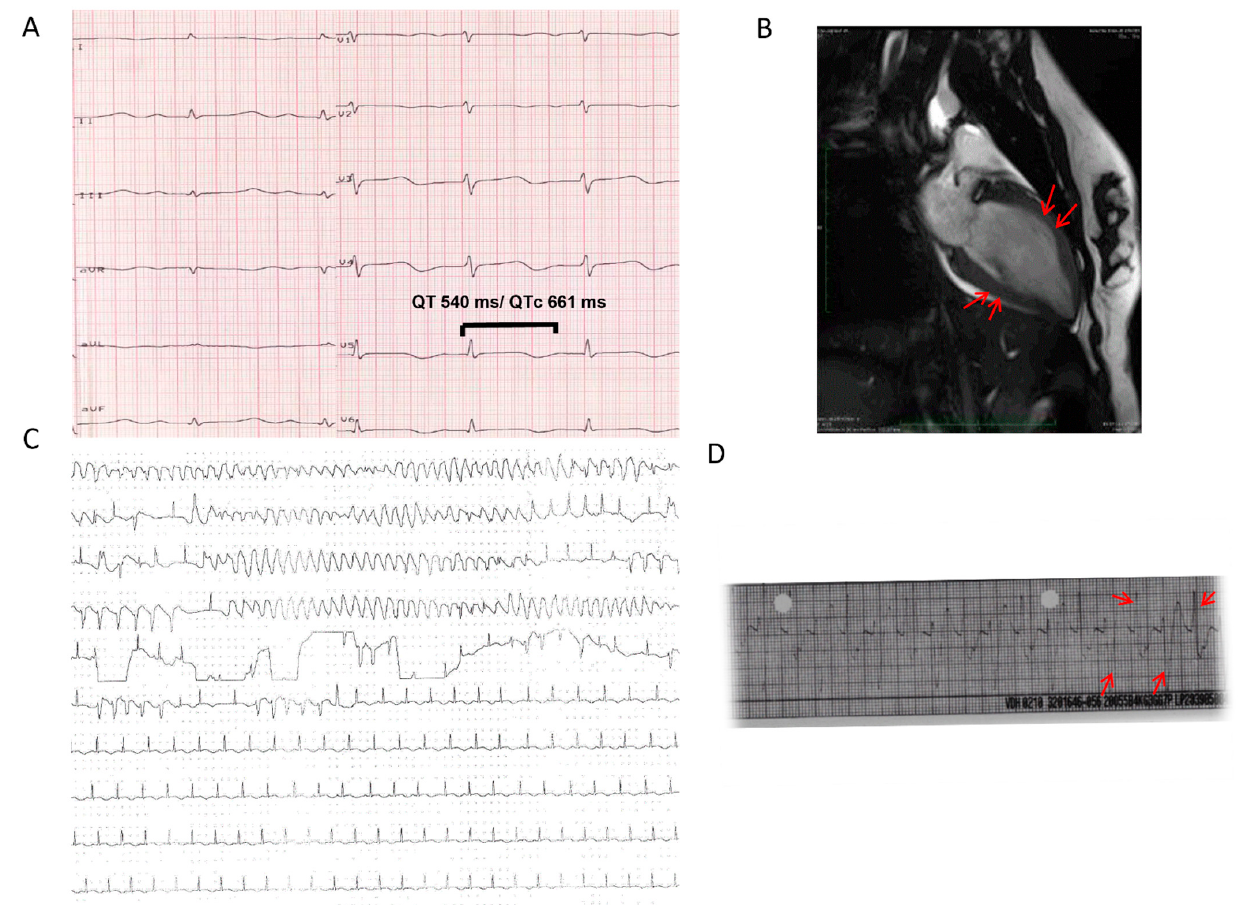
Figure 1. ( A ) ECG at TTS event of 72-year-old female patient presented prolonged QTc interval at TTS event. Due to intolerance of beta-blockers and ongoing prolonged QTc interval in regular follow-ups, an s-ICD has been implanted. A genetic screening confirmed a mutation in the KCNQ1 gene. ( B ) Cardiac magnetic resonance of 18-year-old female patient with a bidirectional tachycardia